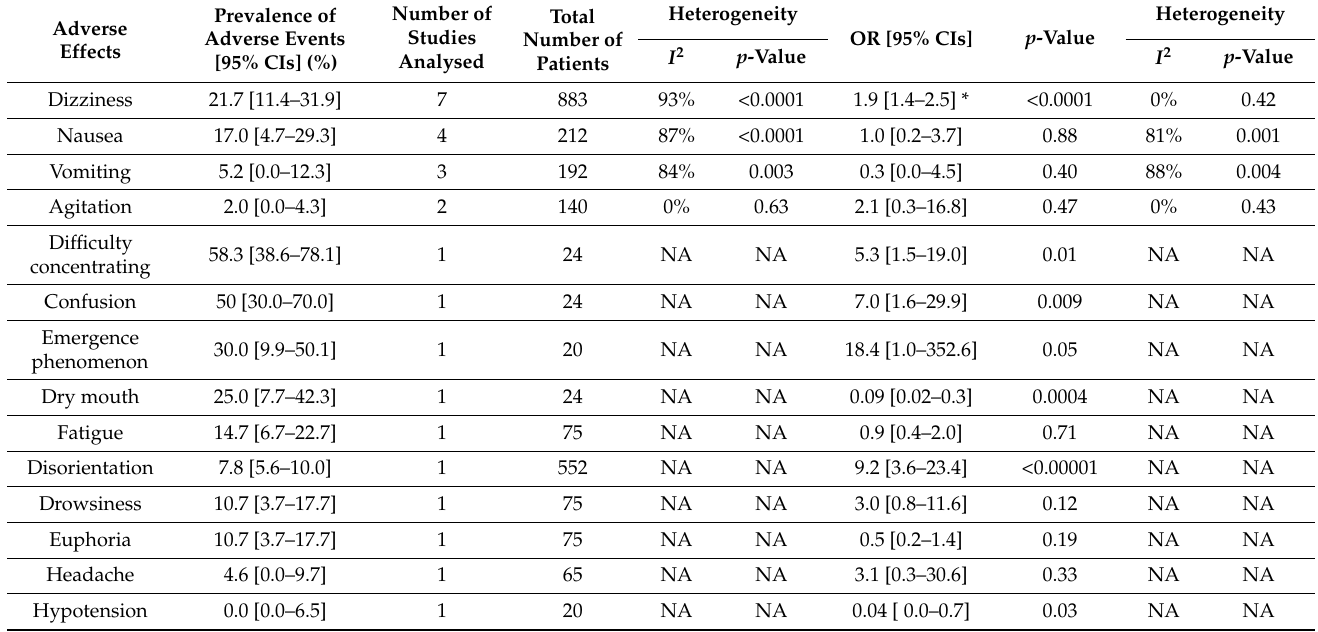
Table 2. Adverse